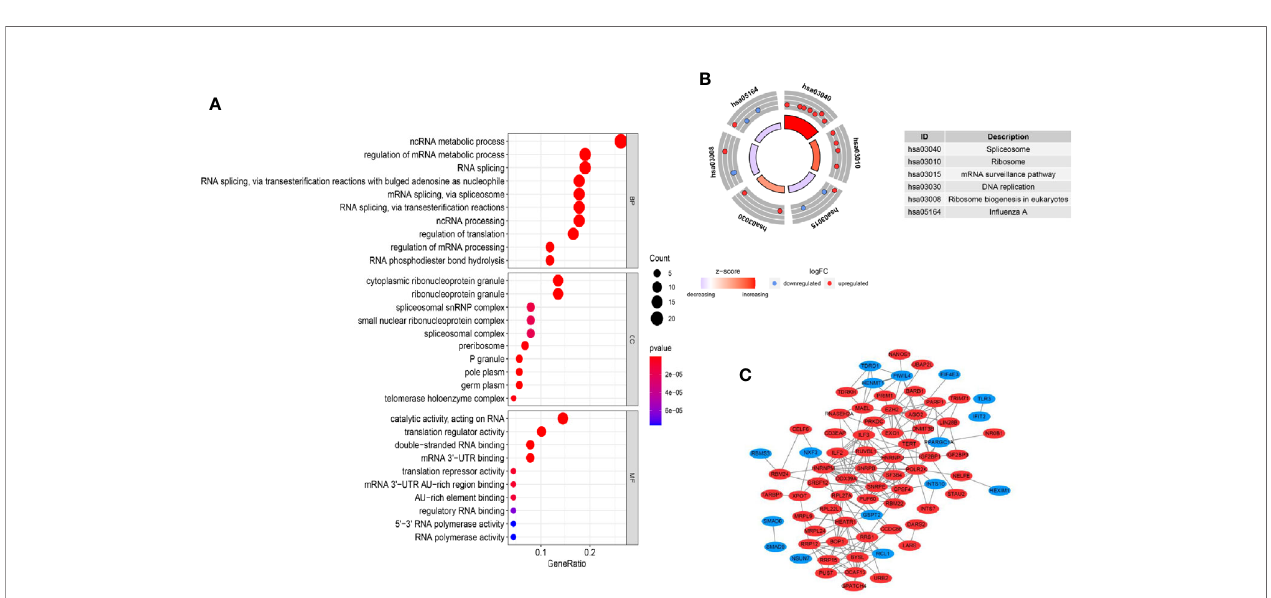
FIGURE 2 | GO, KEGG enrichment analysis and PPI network. (A) GO analysis of differently expressed RBP genes. MF: molecular function; CC: cellular component, BP: biological process; (B) KEGG analysis of differently expressed RBP genes. (C) PPI network of differently expressed RBP genes.